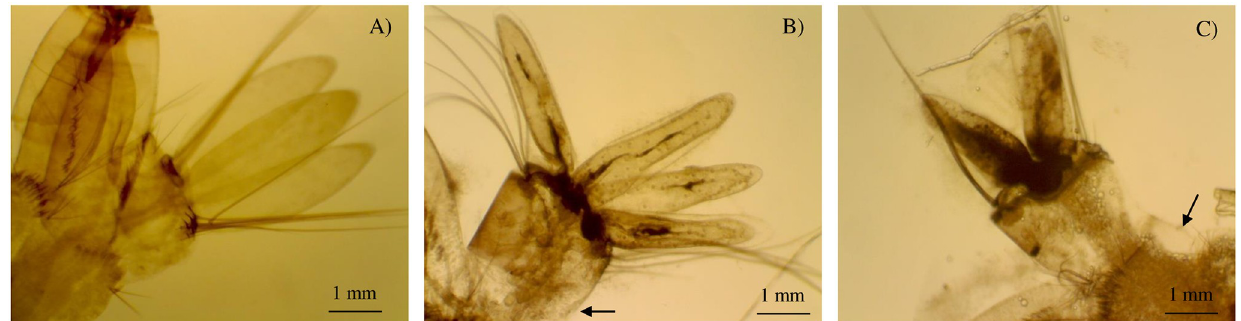
Fig 4. Morphological changes in the anal papillae of A . aegypti 3 rd instar larvae in contact with nano-emulsions of morphopotype A essential oil (B) and morphotype B (C) of A . triplinervis compared to control (A) by confocal microscopy (25 × ).